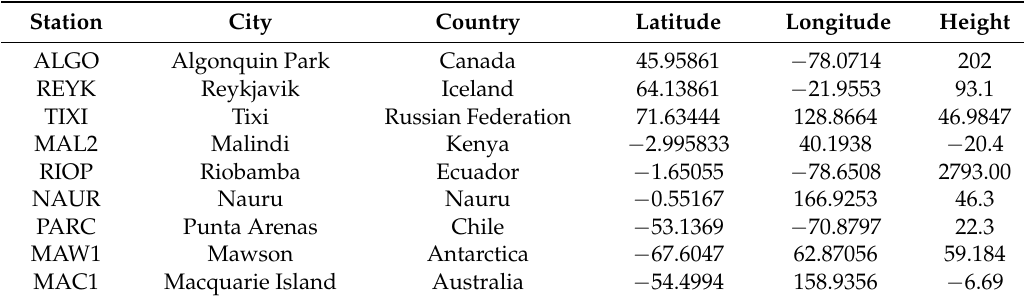
Table 2. Summary of IGS stations chosen for the